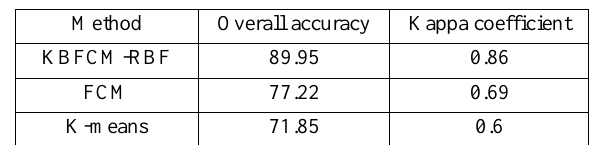
Table 2. Comparisons between kernel-based and conventional methods